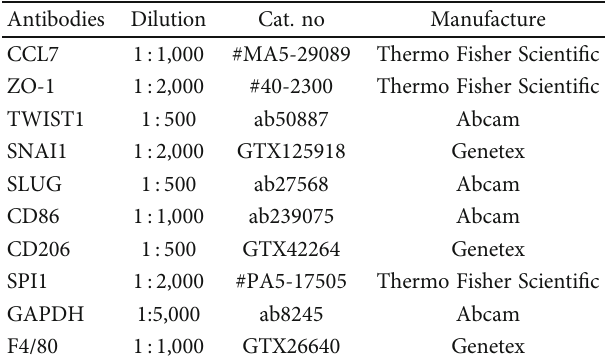
Table 3: Antibodies, dilution rates, the catalogue numbers, and the